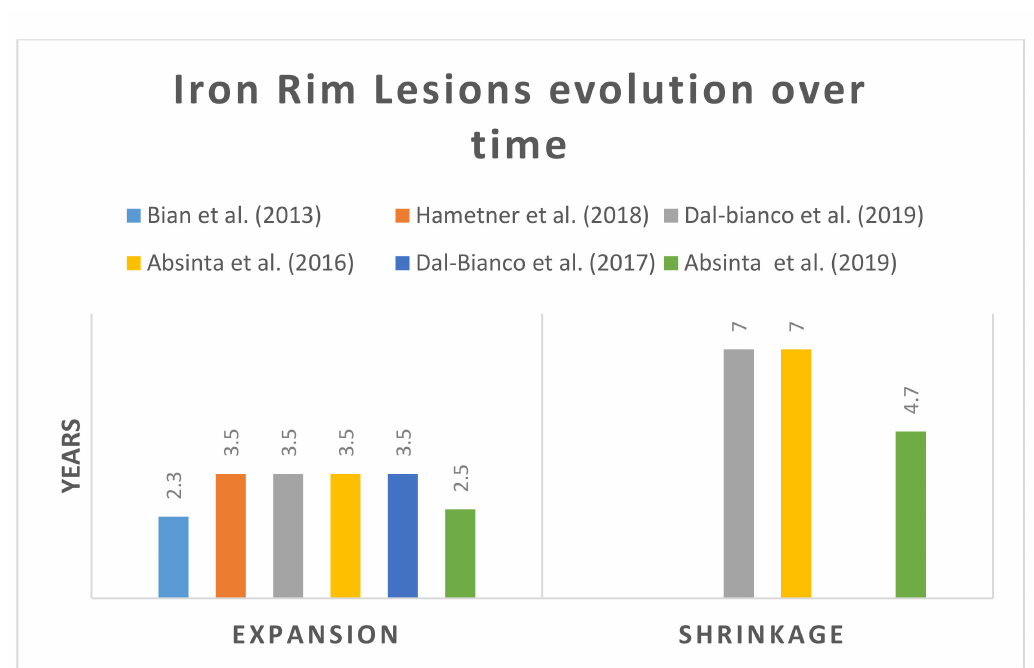
Figure 6. Illustrates the prevalence of IR detected in MS patients. Numbers of patients with at least one IR are